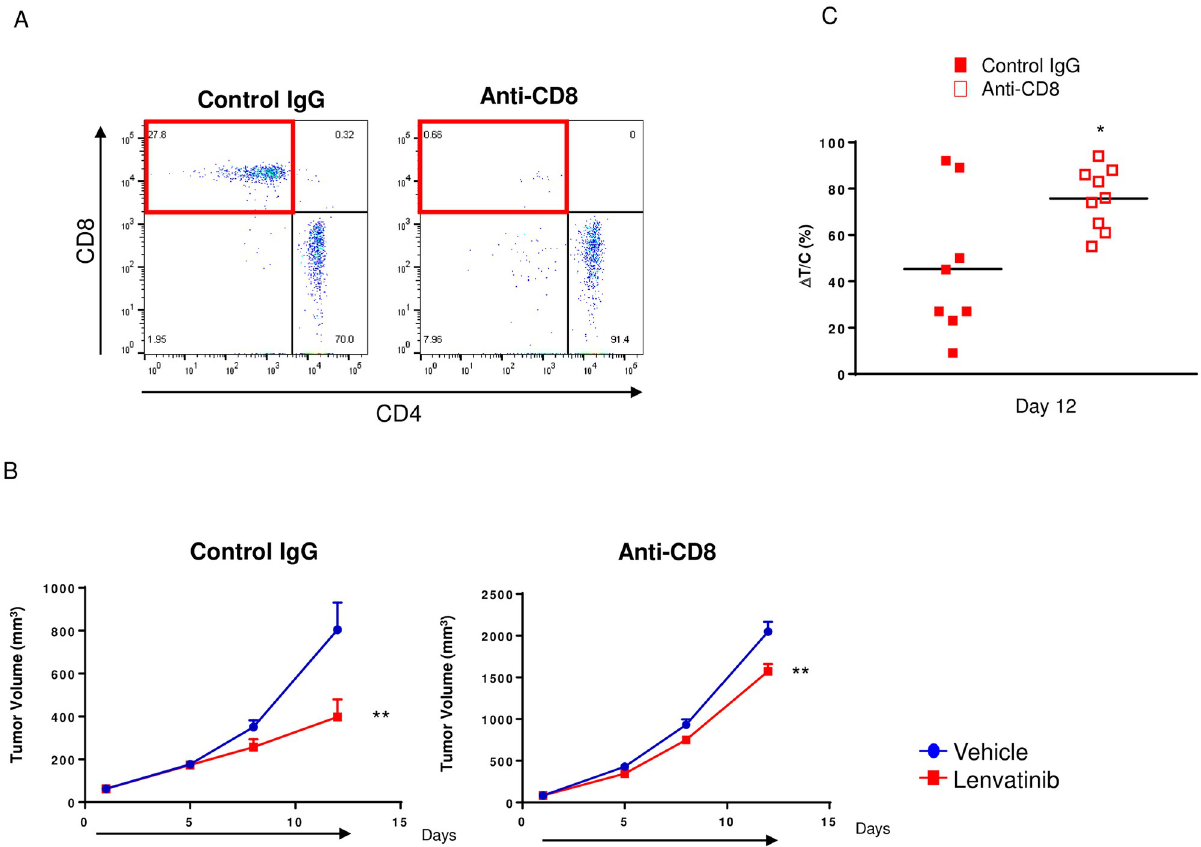
Fig 2. Antitumor activity of lenvatinib under CD8 + T cell-depleted conditions in the CT26 model. Mice, inoculated with CT26 cells, were treated with anti-CD8 antibody or control IgG on Day 6 and twice weekly thereafter. A. For flow cytometric analysis, the percentage of CD8 + T cells in the blood was determined. B. Two days after the first injection of anti-CD8 antibody or control IgG, mice were randomized into groups of 8 or 9 with an average tumor volume size (Day 1 mean TV: anti-CD8 antibody, 65.9 mm 3 ; control IgG, 49.3 mm 3 ), and then treated with vehicle (blue circles) or 10 mg/kg lenvatinib (red squares), indicated by the black arrow. Error bars represent the SEM. C. The percentage of Δ T/C (tumor size of each mouse treated with lenvatinib divided by the average tumor size of vehicle-treated mice) is shown for the control IgG (red-filled squares) and anti-CD8 antibody (red-open squares) treatment groups. �� , P < 0.01, Dunnett’s test vs. vehicle or control IgG ( n = 8 or 9).